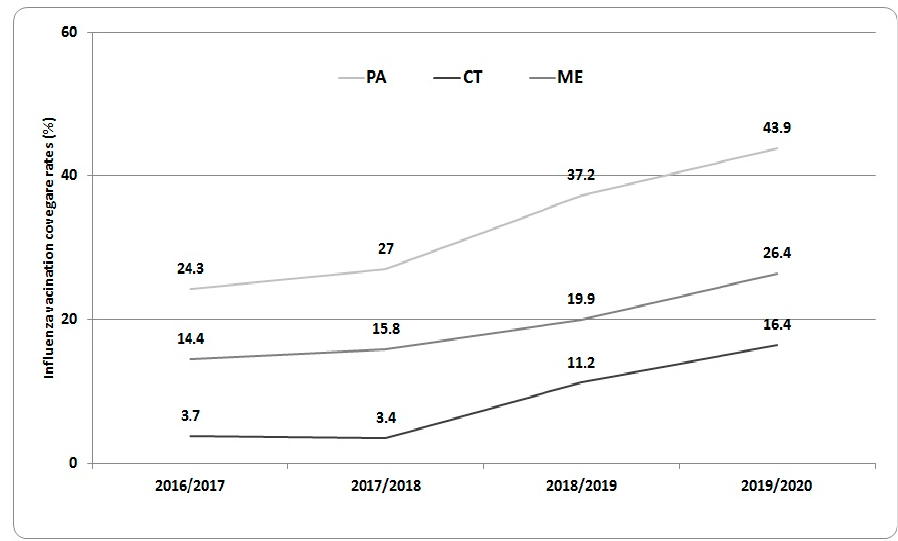
Figure 2. Influenza vaccination coverage rates against seasonal influenza observed during the last four influenza seasons (from 2016/2017 to 2019/2020) at the UHs of Catania, Messina, and Palermo (students and trainees were removed from analysis).